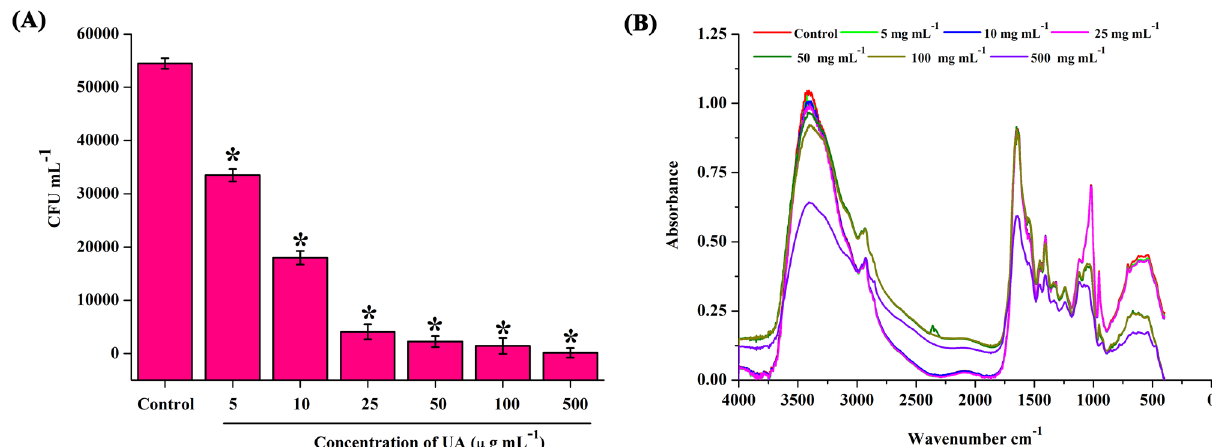
Figure 7. Mature biofilm disruptive potential of UA. S. mutans cells in the preformed biofilm mature biofilm was found to be influenced by the UA treatment. (A) Significant reduction in the viable cells was observed in a concentration dependent manner. (B) Variation in the functional group of the biofilm cells in the absence and presence of UA. Major alterations in the region such as 3800–3000 cm −1 and 1900–600 cm −1 were observed which corresponds to absorptions of fatty acids and proteins respectively. Data are mean ± SD (n = 3) and Asterisk represent significant difference compared with the untreated control ( p <